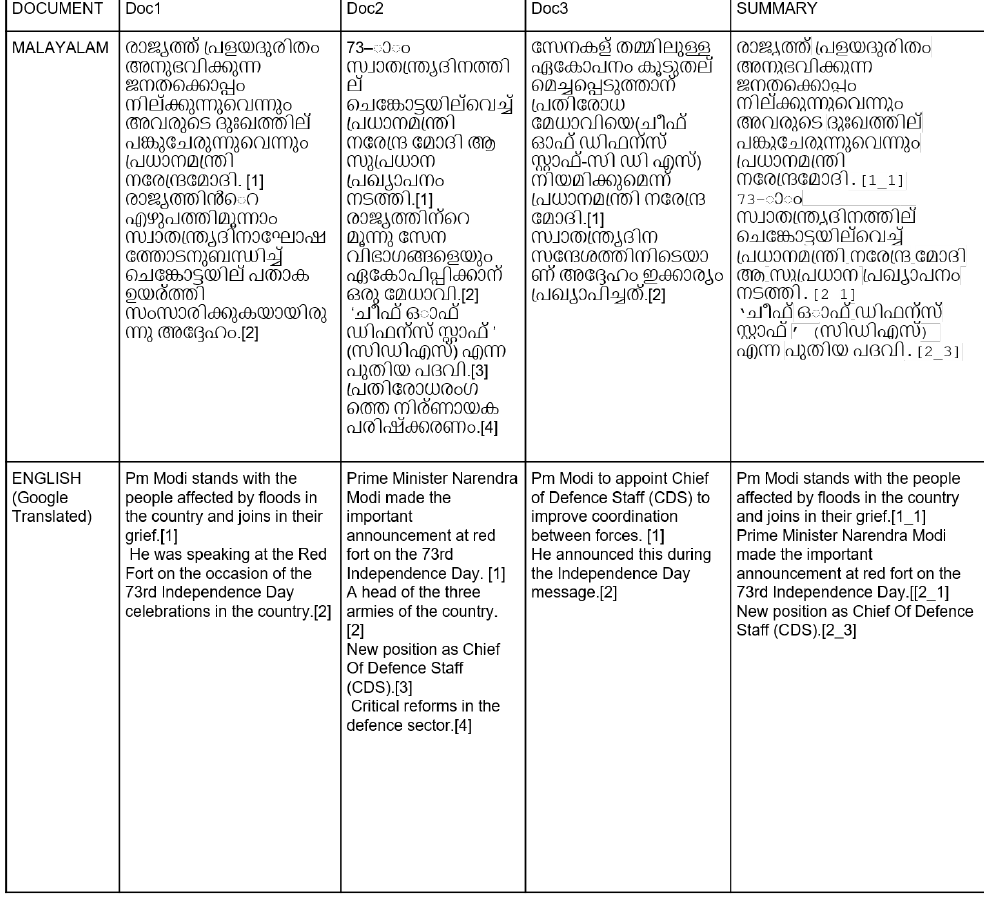
Figure 4. Sample Output of the Framework for Extractive MDS. As it is difficult to show the entire document, as a sample we have taken documents with only a few sentences. The index of a sentence, [2_1] denotes sentence 1 in